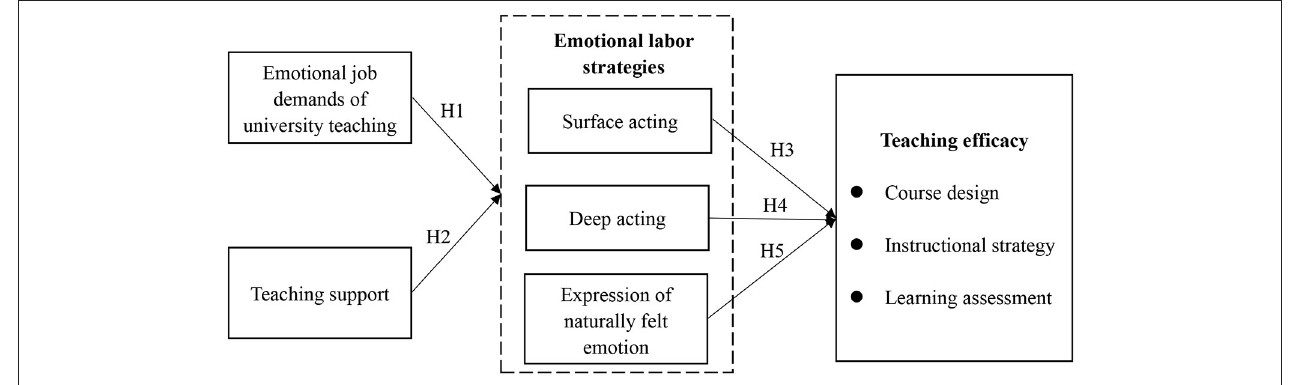
FIGURE 1 | The hypothesized